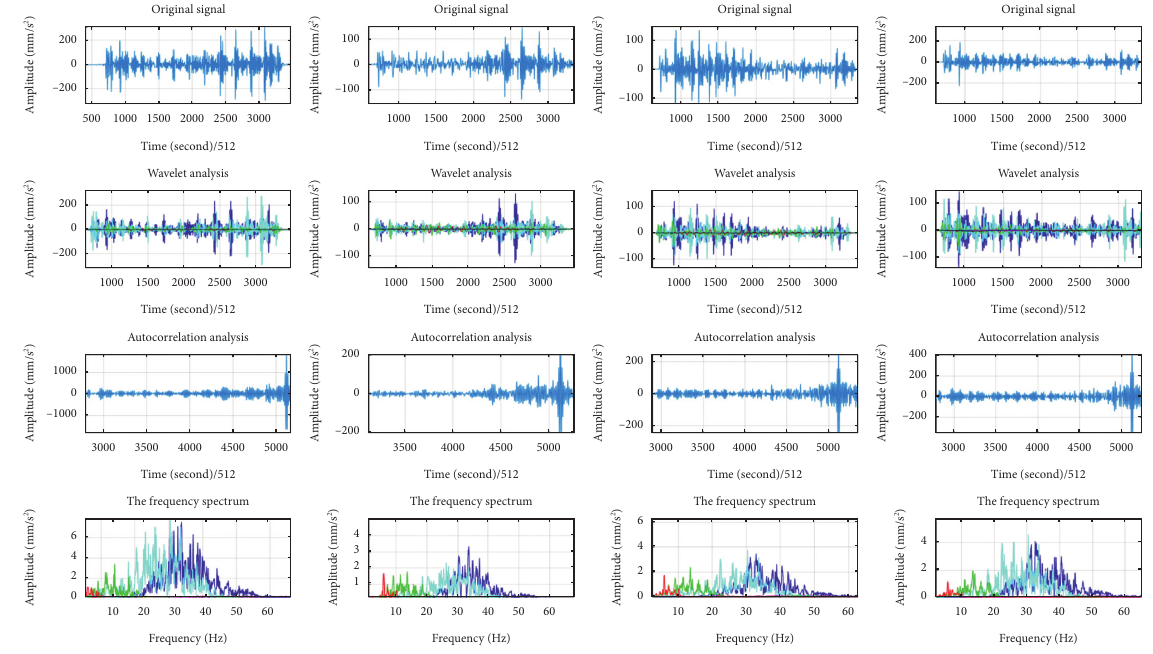
Figure 13: Actual vehicle model running on bridge in case